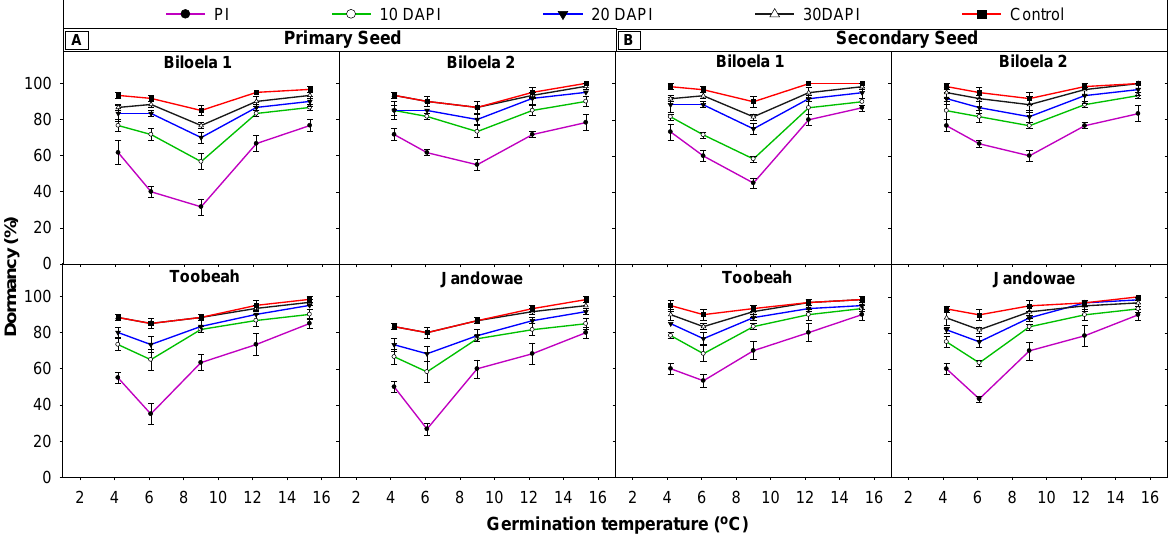
Figure 6. Effect of elevated temperature applied at panicle initiation (PI), 10 days after panicle initiation 10 DAPI, 20 DAPI or 30 DAPI, on the dormancy (%) of freshly harvested ( A ) primary seeds, and ( B ) secondary seeds of four Avena sterilis ssp. ludoviciana biotypes. Error bars represent standard errors of the mean of six replicates of 20 seeds and represent pooled data from two experimental runs.